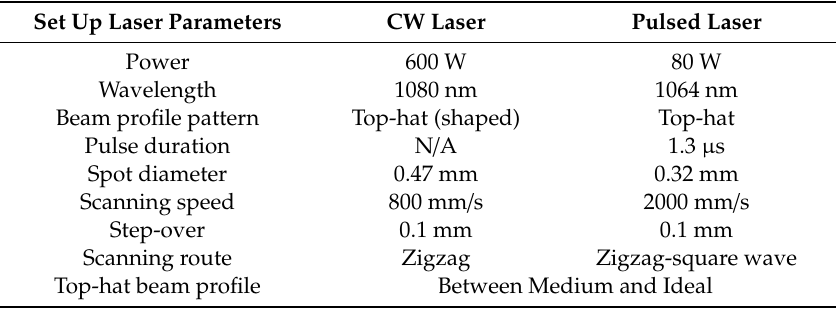
Table 3. Parameters of the dual-beam laser